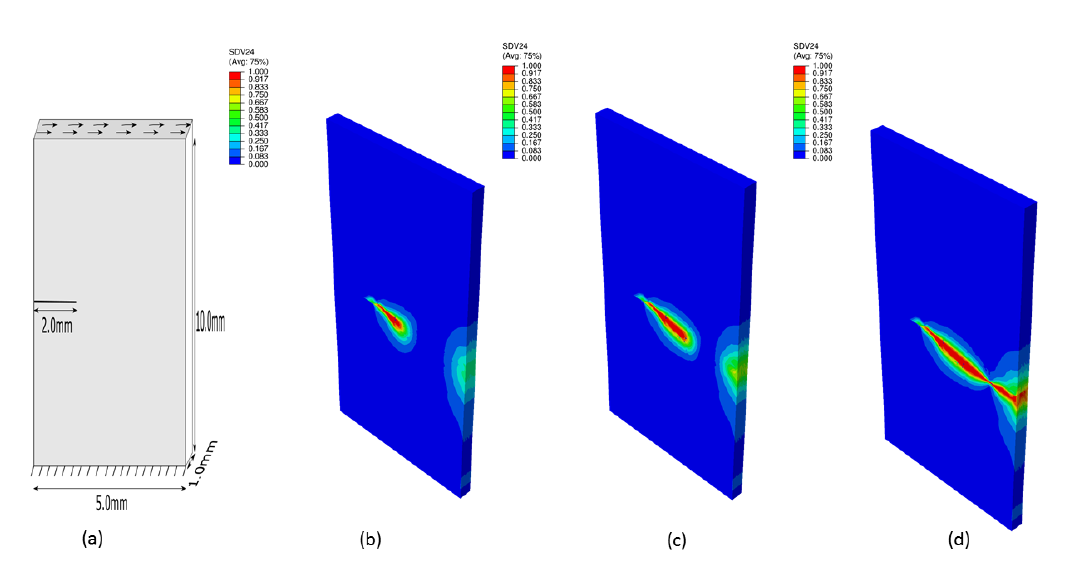
Figure 6. A single edge notched sample under shear loading: ( a ) panel geometry; ( b ) crack initiation; ( c ) crack path after 300 step-times; ( d ) crack path after 500 step-times; and ( e ) final crack path.